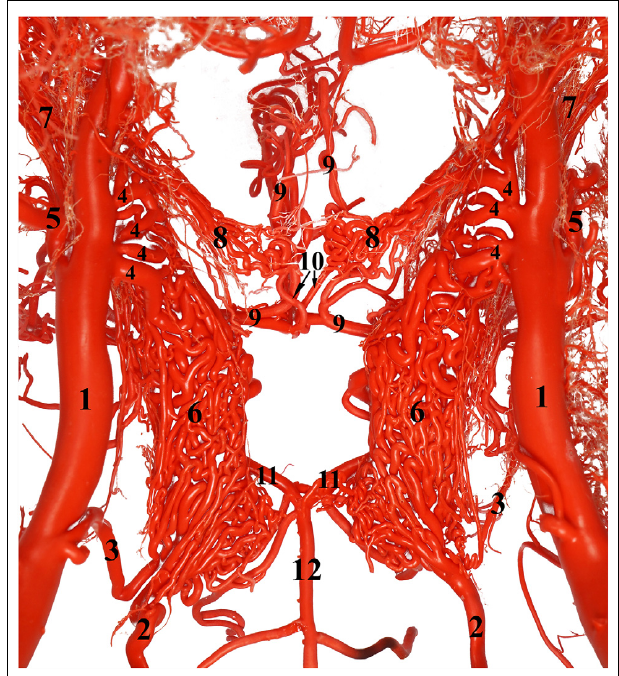
FIGURE 7 | Ventral view of the RERM. 1, Maxillary artery; 2, internal carotid artery; 3, middle meningeal artery; 4, rostral branch to the RERM; 5, external ophthalmic artery; 6, RERM; 7, ophthalmic rete; 8, chiasmatic rete; 9, rostral cerebral artery; 10, internal ophthalmic artery; 11, caudal communicating artery; and 12, basilar artery leading to the cerebral arterial circle. Note: middle meningeal artery was a dominant supplier to RERM in this